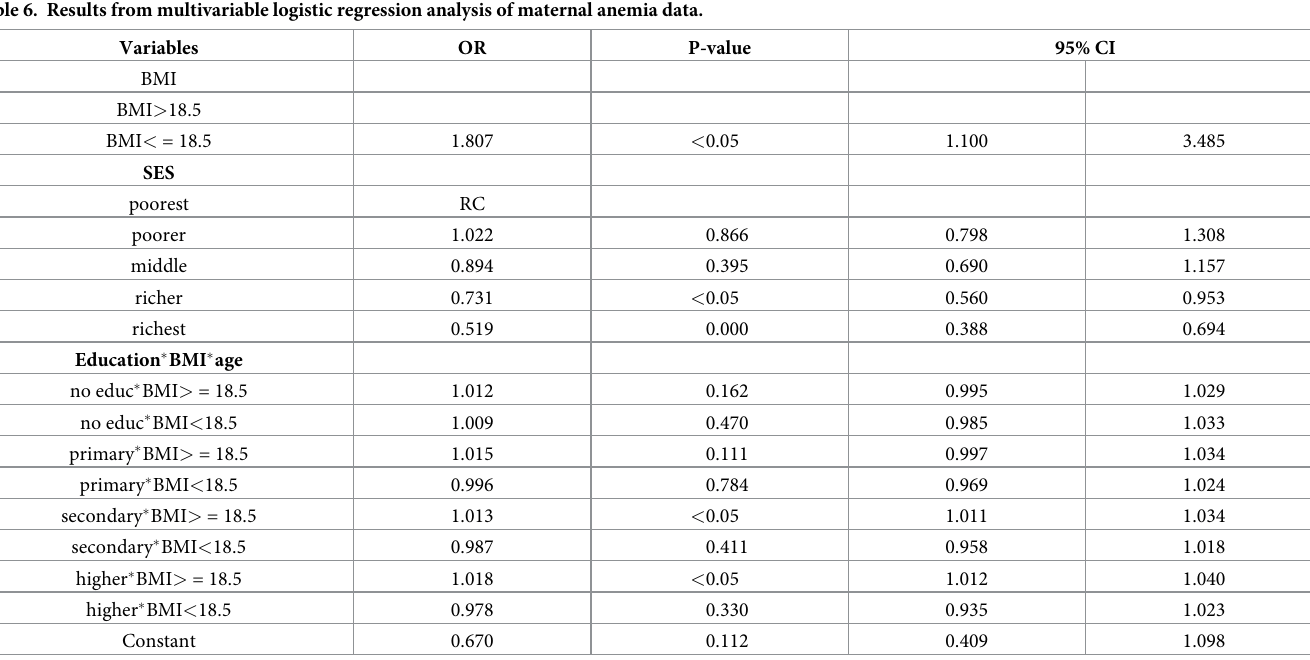
Table 6. Results from multivariable logistic regression analysis of maternal anemia